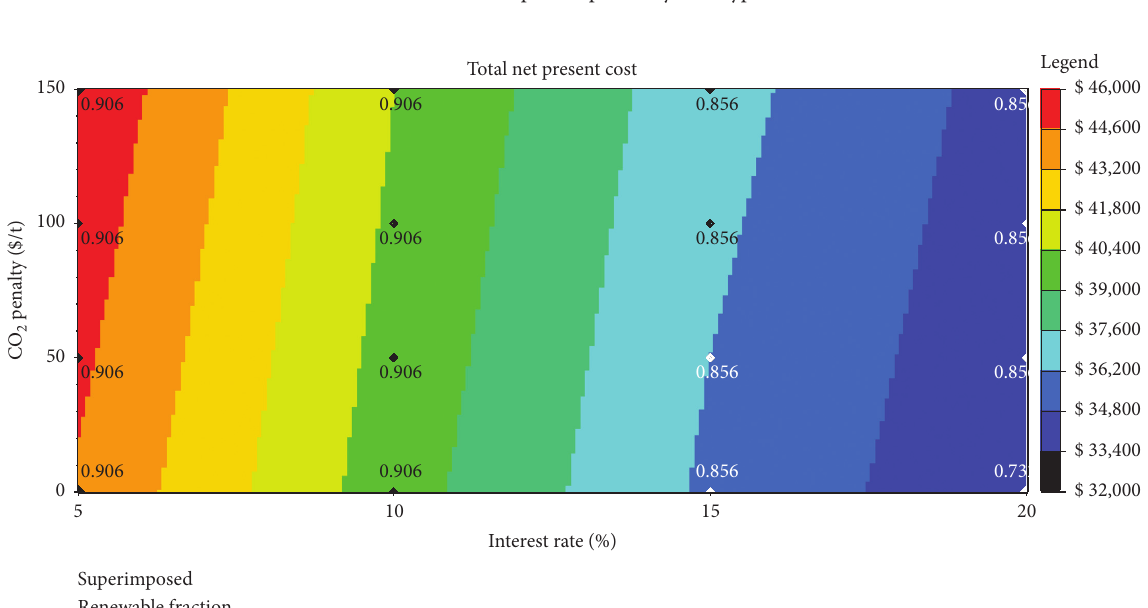
Figure 12: Graph of optimal system type.